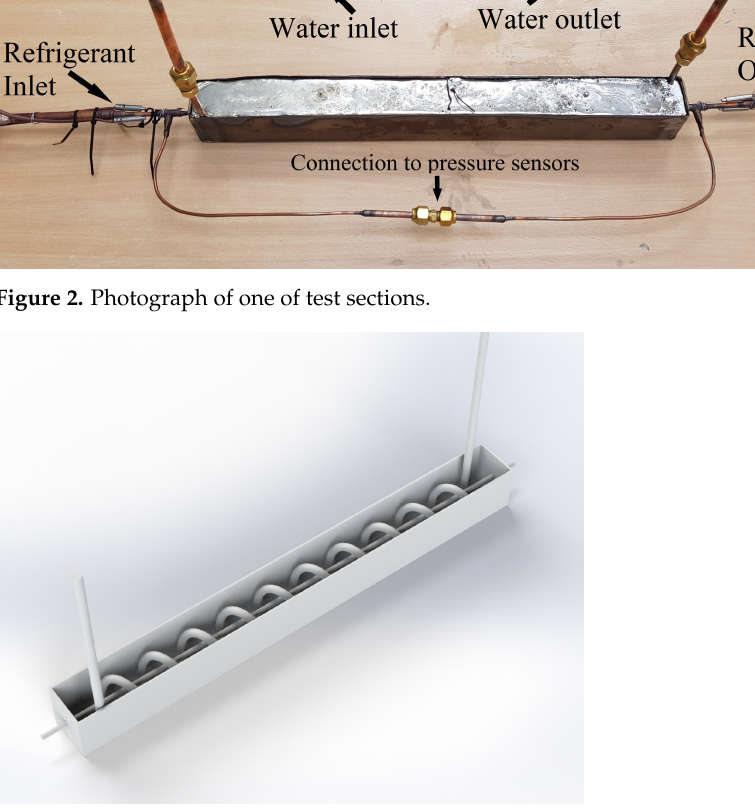
Figure 3. Visualization of test section and the cooling water loop without the filling